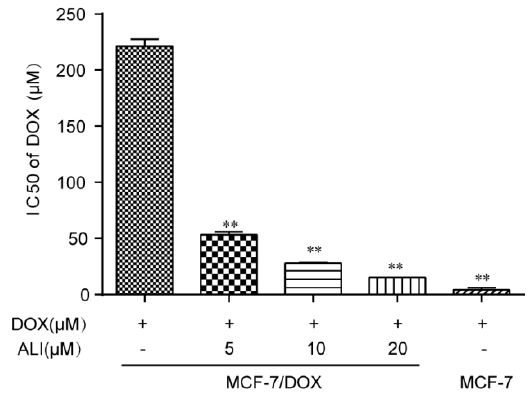
Figure 4. The effect of ALI on chemosensitivity and the effect of ALI on chemosensitivity of doxorubicin in MCF-7/DOX cells. MCF-7 and MCF-7/DOX cells were cultured for 24 h in the absence or presence of ALI (5 µ M, 10 µ M and 20 µ M) with various concentrations of doxorubicin (0.03, 0.1, 0.3, 1, 3,